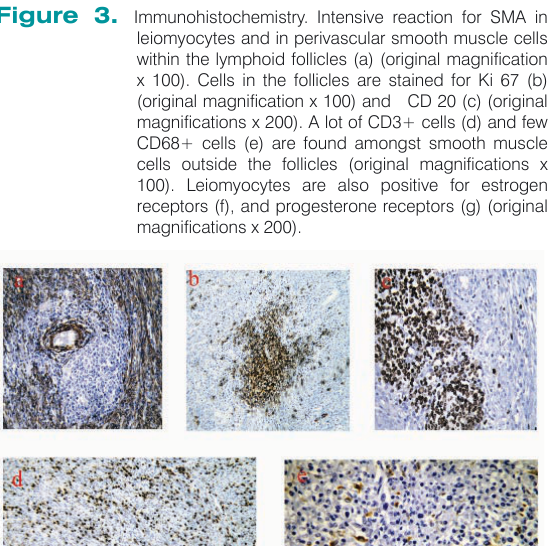
Figure 3. Immunohistochemistry. Intensive reaction for SMA in leiomyocytes and in perivascular smooth muscle cells within the lymphoid follicles (a) (original magnification x 100). Cells in the follicles are stained for Ki 67 (b) (original magnification x 100) and CD 20 (c) (original magnifications x 200). A lot of CD3+ cells (d) and few CD68+ cells (e) are found amongst smooth muscle cells outside the follicles (original magnifications x 100). Leiomyocytes are also positive for estrogen receptors (f), and progesterone receptors (g) (original magnifications x 200).